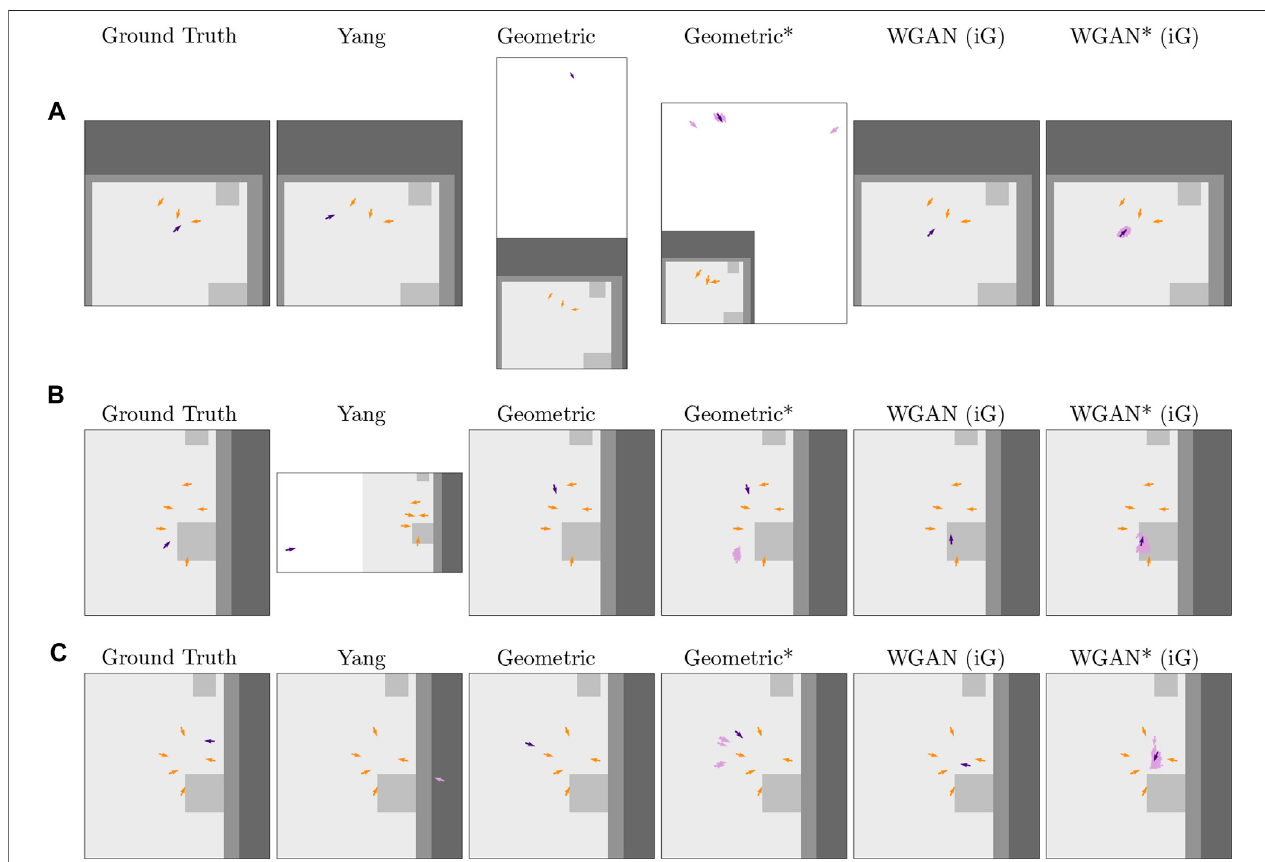
FIGURE7| Dif fi cultpredictionsonthreedifferentproblems(rows)fromtheCocktailPartytestset.Asin Figure6 ,theorangearrowscorrespondtotheposesinthe context C ,thepurplearrowsareGroundTruthorpredictedposes,andthelightergraycolorinthemapscorrespondstofreespace.Whiteareaswithinaplotcorrespond to regions of the space out of the cropped map (considered as “ unknown ” occupancy by the proposed methods). This Figure is best viewed in